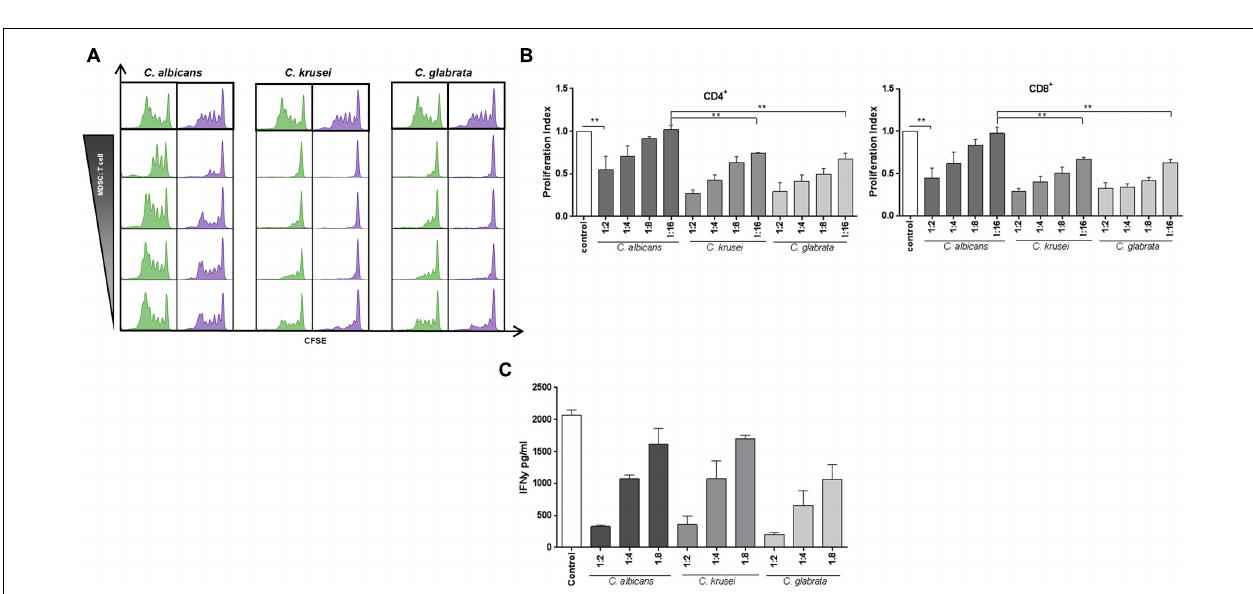
FIGURE 1 | In vitro MDSC generation by different Candida non- albicans species and C. albicans morphotypes. MDSCs were generated by incubating freshly isolated PBMCs (5 × 10 5 /ml) from healthy donors with medium only (negative control) or indicated stimulants. (A) PBMCs were cultured with heat killed yeast cells of C. albicans, C. glabrata, C. krusei, C. parapsilosis , and C. dubliniensis (1 × 10 5 /ml) for 6 days ( n = 11–20) or (B) with heat killed C. albicans yeast cells (1 × 10 5 /ml), filter sterilized C. albicans yeast supernatant (5% SNT), or C. albicans hyphae (1 × 10 5 /ml) for 6 days ( n = 8–13). Granulocytic MDSCs (CD11b + CD33 + CD14 − ) were quantified by using Flow Cytometry. The number of MDSCs in % of all cells in medium only cultures was set to 1-fold for every single experiment. The MDSC induction due to specific stimuli is presented as x-fold compared to medium control (mean ± SEM) and differences compared to controls were analyzed by a one-sample t -test. Significant differences between control and G-MDSCs induction by stimulants are indicated by an asterisk ( ∗ P < 0.05; ∗∗ P < 0.01; ∗∗∗ P < 0.001; ∗∗∗∗ P < 0.0001).